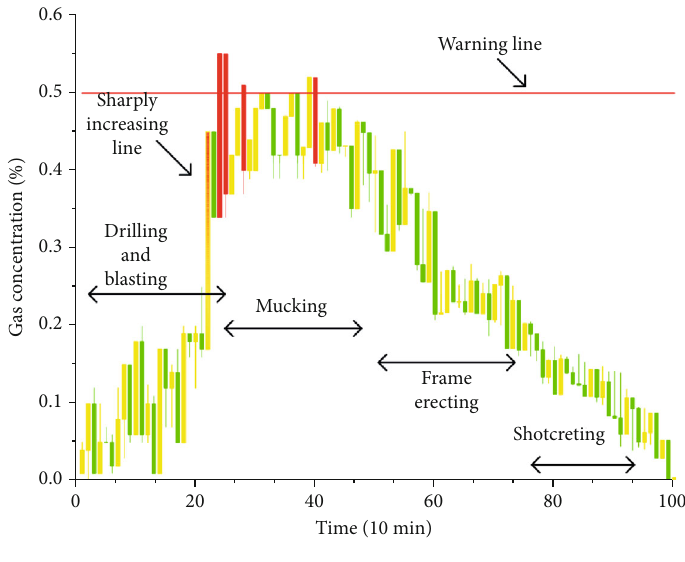
Figure 4: K-line diagram of gas concentration.